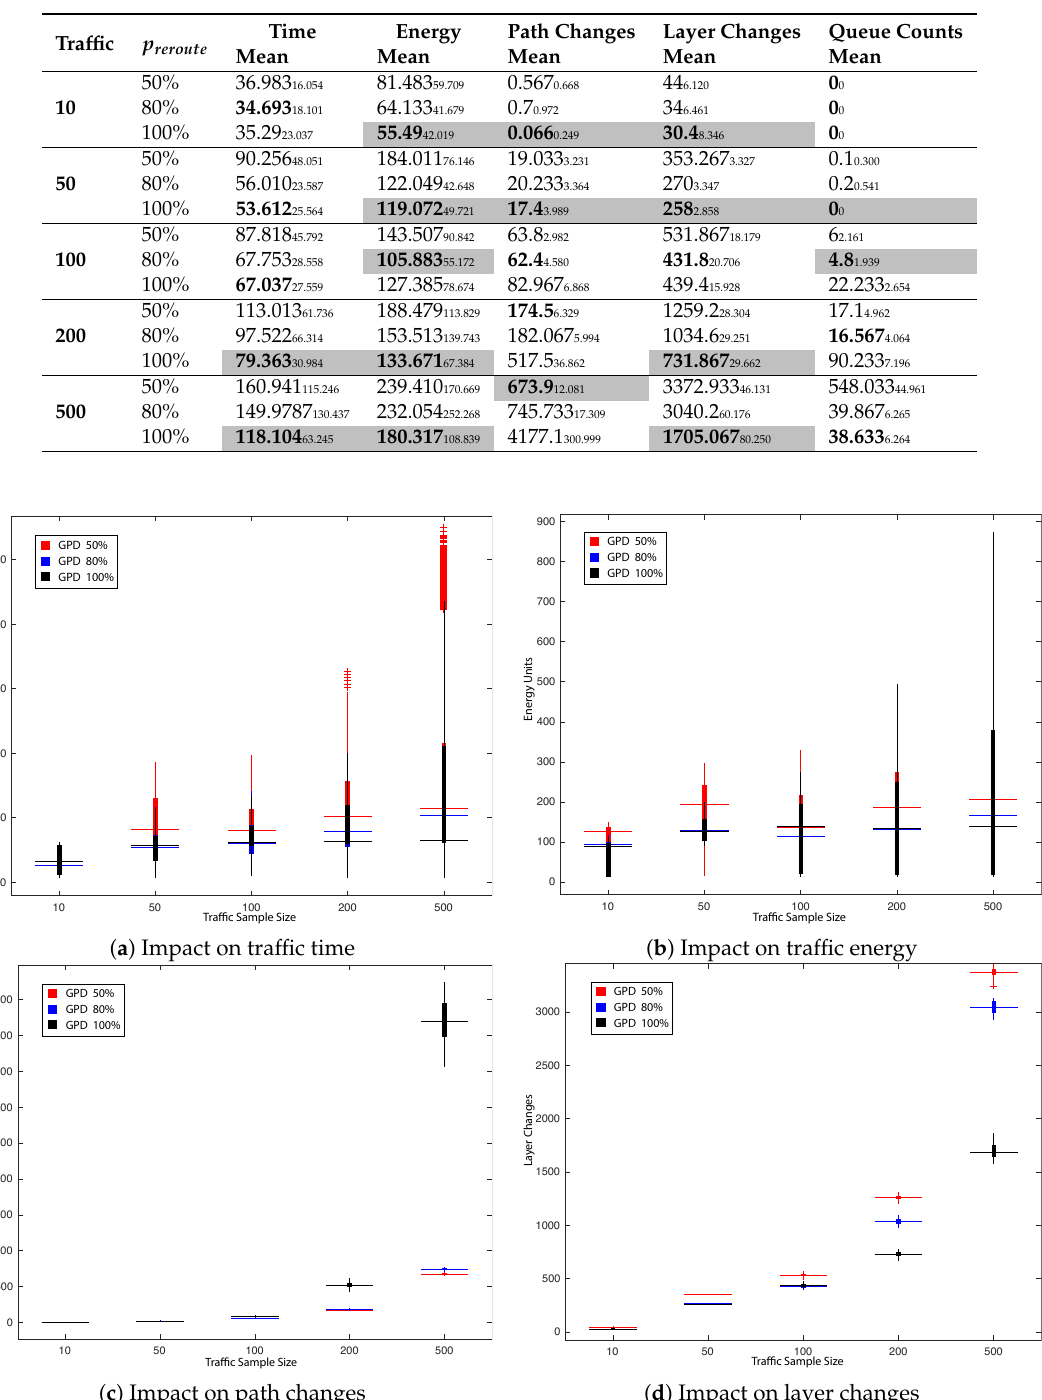
Table 3. Impact on mixed objective traffic performance from varying p reroute in GPD (50%, 80%, 100%).